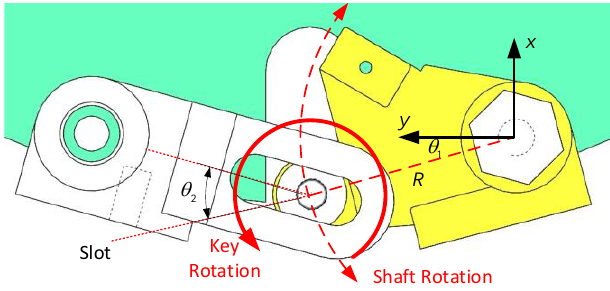
Figure 4. Motion analysis for the key during the assembly process.